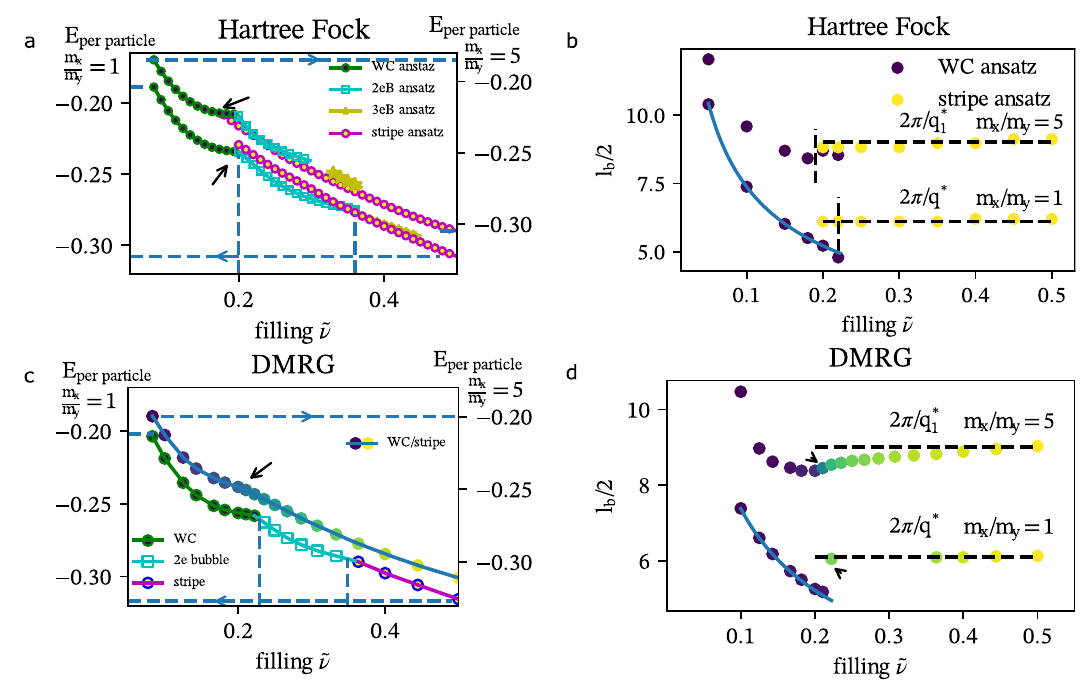
Fig. 2 The energy and the lattice constants of different phases. a The energy per particle of different phases as a function of fi lling ~ ν at mass ratio m m = 1 and m m = 5, computed in the Hartree – Fock (HF) approximation in the unit of e 2 / l . b The lattice constants of the Wigner crystal and the stripe x / y x / y from HF calculation. We present the half diagonal length l b /2 of the rhombus unit cell and the stripe period. The dashed lines are the length scales set by the HF minimum 2 π / q * at m x / m y = 1 and 2 π = q (cid:4) at m x / m y = 5. The solid blue line represent the value l 1 lattice. As the stripe phase takes a unidirectional form in the HF ansatz, there is a discontinuity for m x / m y = 5 because of different symmetry orders. But further DMRG calculation reveals that quantum fl uctuations lead to stripe crystal at this fi lling and smooth the discontinuity. c The energy per particle of the ground state at each ~ ν by DMRG calculations. d The half diagonal length l b /2 of the Wigner/stripe crystal from DMRG calculations. The colour represents the stripe-direction modulation as in Fig. 1b. The absence of some data points of ( d ) comparing to ( b ) is due to that stripe phase cannot be realised as a stable state in this